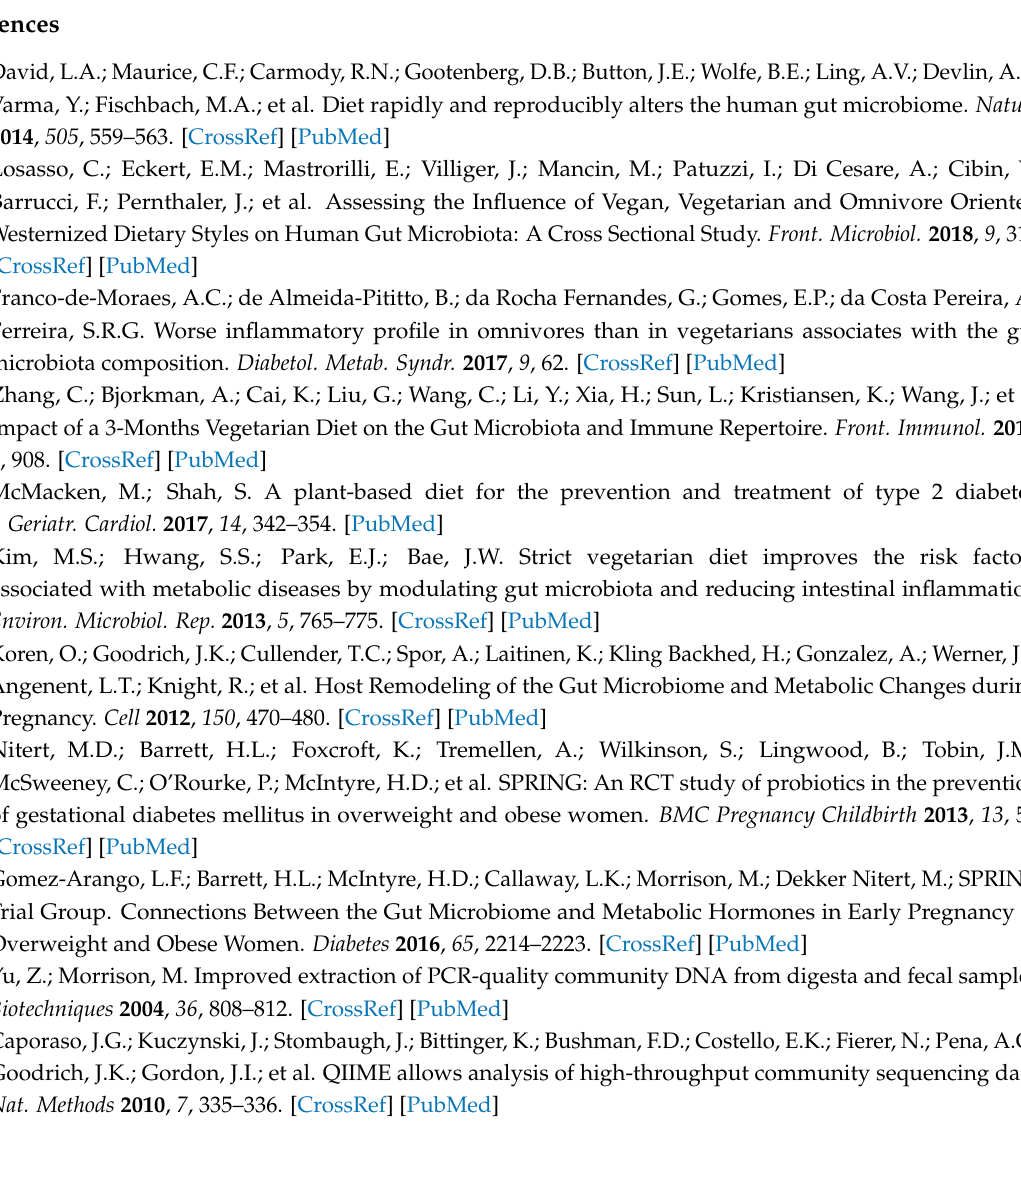
Figure S1: Alpha diversity analysis on Phylum level, Figure S2: Alpha diversity analysis on Genus level, Figure S3: Alpha diversity analysis on OTU level, Figure S4: Beta diversity analysis on OTU level, Figure S5: (A) Group comparison (B) LEfSe analysis on family level, Figure S6: Group comparison on OTU level, Figure S7: Group comparison on OTU